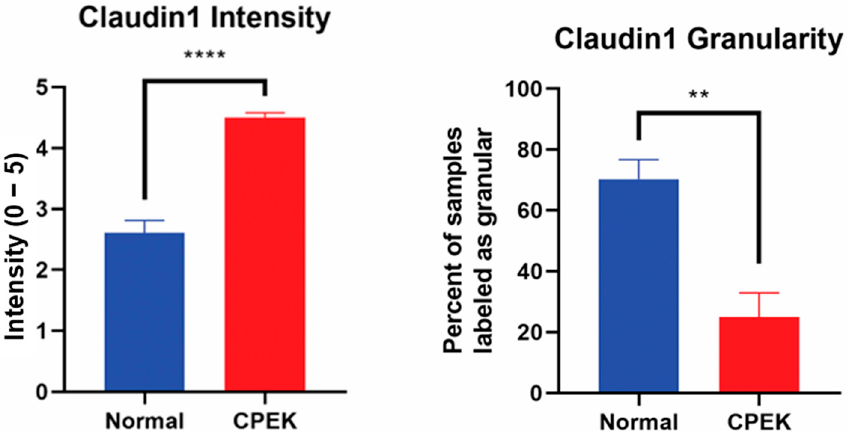
Figure 6. On the left, mean scores of the intensity of claudin-1 staining. Observers rated intensity from 0–5. Observer scores were averaged for each picture. Normal vs. canine progenitor epidermal keratinocyte (CPEK) cells scores were shown to be significantly different using welch unequal variance t -test with a p -value of <0.0001. On the right side, see the percent of samples labeled “granular” by the observers for the claudin staining. Observers were asked to labeled staining either granular or smooth. Normal vs. canine progenitor epidermal keratinocyte (CPEK) cells scores were shown to be significantly different using welch unequal variance t -test with a p -value of 0.0012. **** indicates a significance p less than <0.0001 while ** indicates a significance of p higher than 0.001.